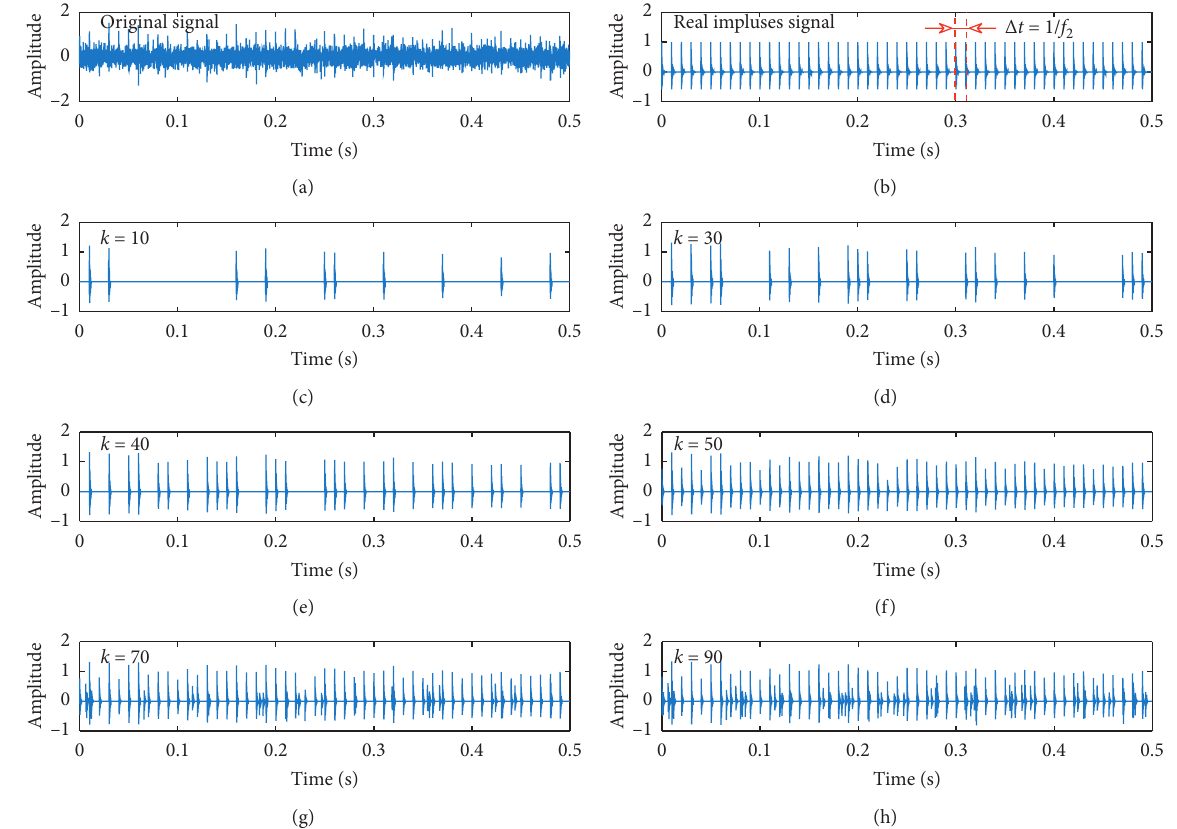
( t ) ; (b) real impulses signal in s ( t ) ; and 2 2